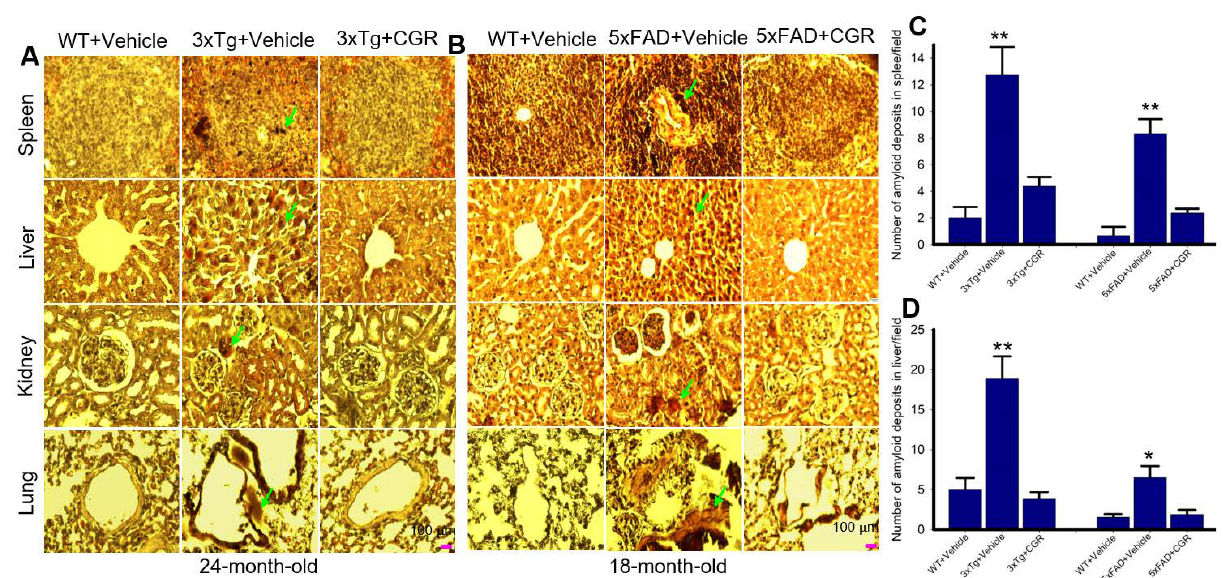
Figure 10. Amyloid deposition was reduced by CGR treatment in 3xTg and 5xFAD mice spleen, liver, kidney and lungs. After treatment with CGR (100 mg/kg) for 2 months, the WT, 3xTg and 5xFAD mice were perfused with PBS and fixed with 4% paraformaldehyde and the spleen were dissected out, embedded with paraffin and sectioned at 5 µ m. The amyloid deposition was stained with Congo-red dye, followed using a counterstain with hematoxylin and the images were taken by compound light microscope with a 40 × objective (total magnification = 400 × ). ( A , B ) Representative photomicrographs of the spleen, liver, kidney and lungs from 24-month-old 3xTg mice ( A ) and 18-month-old 5xFAD mice ( B ) after treatment with CGR. ( C , D ) Note that both the 3xTg and 5xFAD mice increased amyloid deposition (green arrows) in spleen ( C ), liver ( D ) and other tissues (graph not shown), whereas CGR treatment reduced the amyloid deposits in all these tissues. Scale bar = 100 µ m and is applicable to all other images. * p < 0.05 and ** p < 0.01 in comparison to WT+Vehicle and